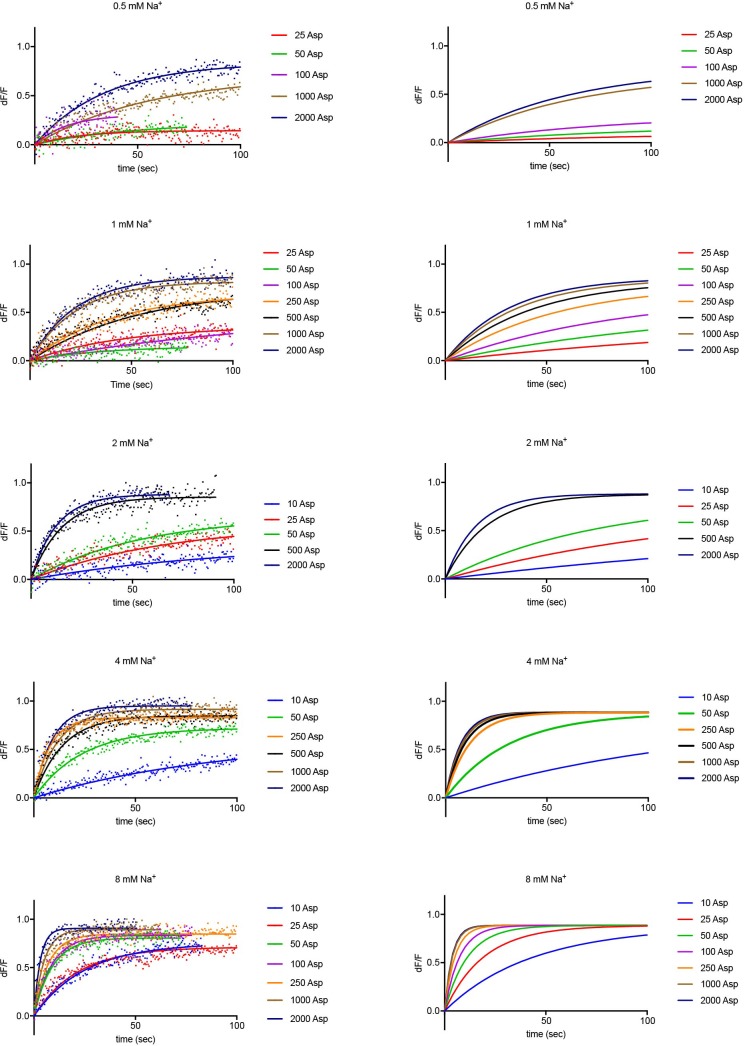
Experimental and simulated kinetics of L-asp binding to P11WIFS.Left panels: Kinetics of L-asp binding measured upon addition of the indicated Na+ (mM) and L-asp (μM) amounts. Data are fitted to single exponential functions. For brevity, single representative experiments are shown from sets of triplicates under each experimental condition. Color scheme is as follows: blue, 10 µM red, 25 μM; green, 50 μM; purple, 100 μM; orange, 250 μM; black, 500 μM; ocher, 1000 μM; navy blue, 2000 μM L-asp. The simulations using values obtained in global fitting of the data are shown on the right panels.